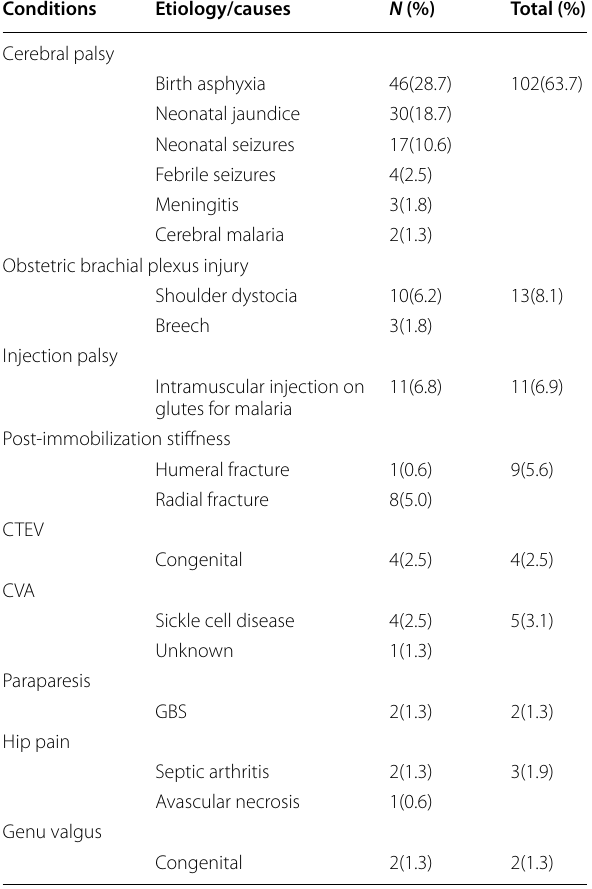
Table 2 Conditions managed by physiotherapists and etiology Conditions